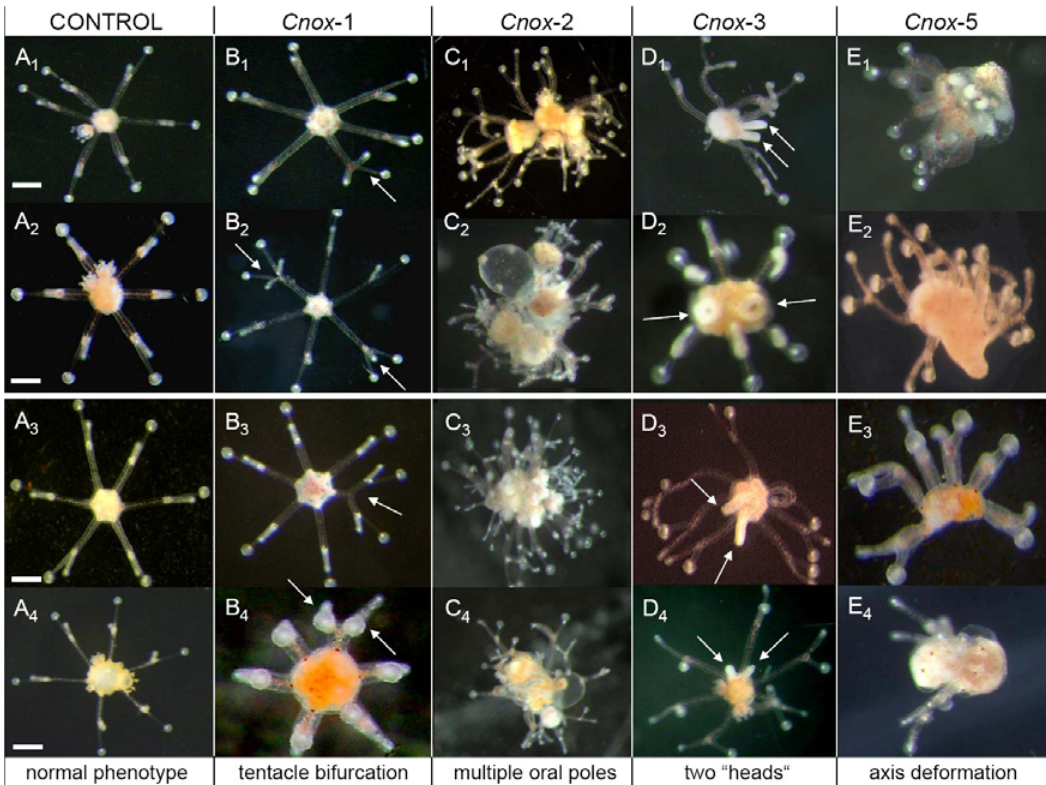
Figure 1. Observed phenotypic changes in knock down experiments of Hox-like genes in the hydrozoan Eleutheriadichotoma. Four of the five Hox-like genes produced p henotypically a bnormal m edusae (PAMs) in gene knock down studies. The main features of bauplan change relate to additional tentacle bifurcation ( Cnox -1; see arrows), multiple oral poles or heads ( Cnox -2), head duplication ( Cnox -3; see arrows), and oral-aboral body axis deformation ( Cnox -5). The two upper panels show life pictures of medusae transfected with double stranded RNA (B 1,2 , C 1,2 , D 1,2 , E 1,2 ), and the lower panel medusae transfected with morpholino oligos (B 3,4 , C 3,4 , D 3,4 , E 3,4 ). A 1,2 and A 3,4 are controls, scale bar is 100 m m. While we here unambiguously show that Hox-like genes can be silenced we think it would be premature to derive final conclusions on their functions